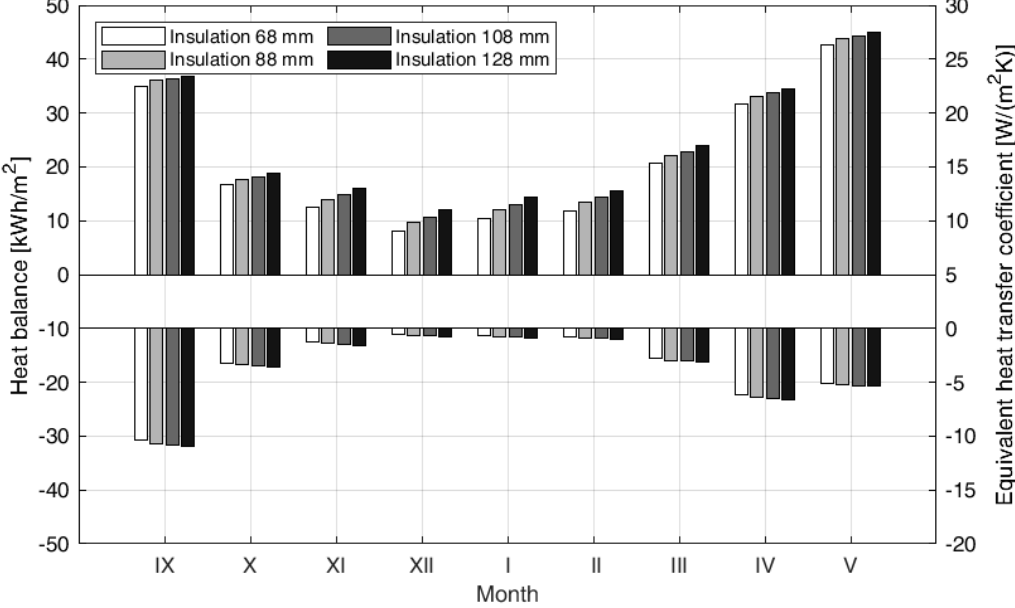
Figure 11. The Q m (upper graph) and U eq (bottom graph) values of the SW-TI for a south orientation in Figure 11. The (cid:1843) (cid:3040) (upper graph) and (cid:1847) (cid:3032)(cid:3044) (bottom graph) values of the SW-TI for a south orientation Figure 11. The (cid:1843) (cid:3040) (upper graph) and (cid:1847) (cid:3032)(cid:3044) (bottom graph) values of the SW-TI for a south orientation the case of the application of insulation of di ff erent thicknesses (location in Racib ó in the case of the application of insulation of different thicknesses (location in Racibórz). in the case of the application of insulation of different thicknesses (location in Racibórz).